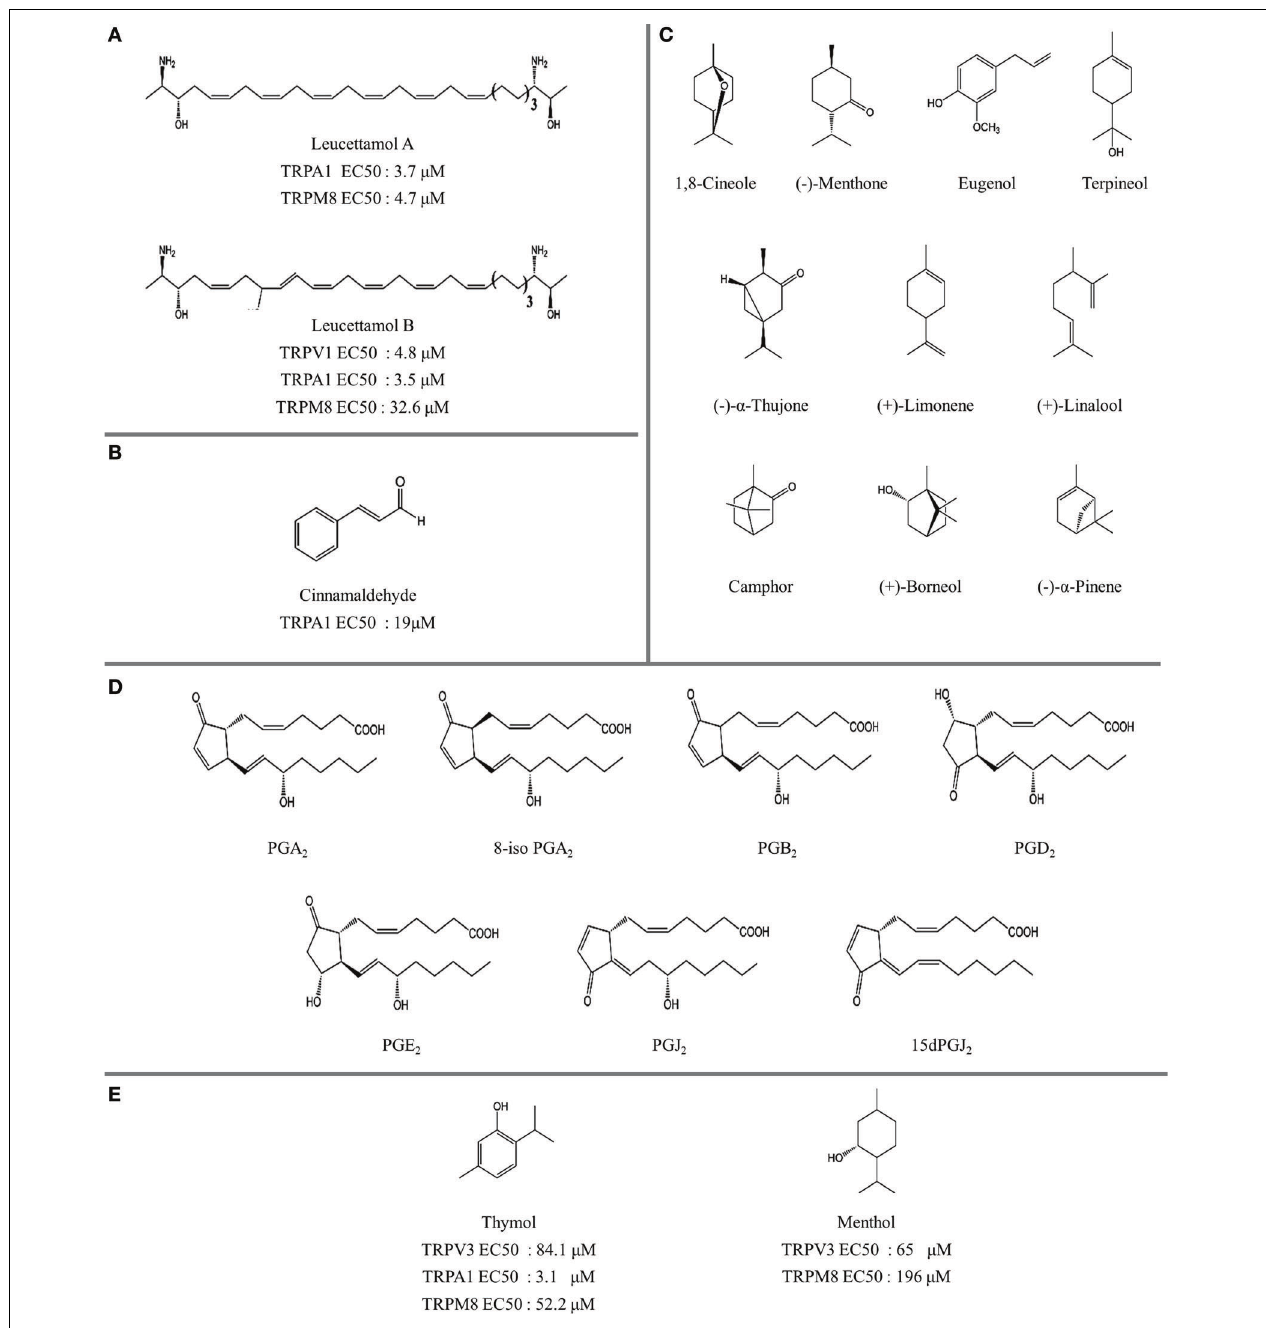
FIGURE 4 | The structure of natural thermoTRP ligands. (A) Leucettamol A and B identified with TRP channel activity (Chianese et al., 2012). (B) Cinnamaldehyde, TRPA1 activator (Macpherson et al., 2007). (C) Structure of monoterpenoids and related compounds evaluated on TRPM8, TRPV3, and TRPA1 receptors